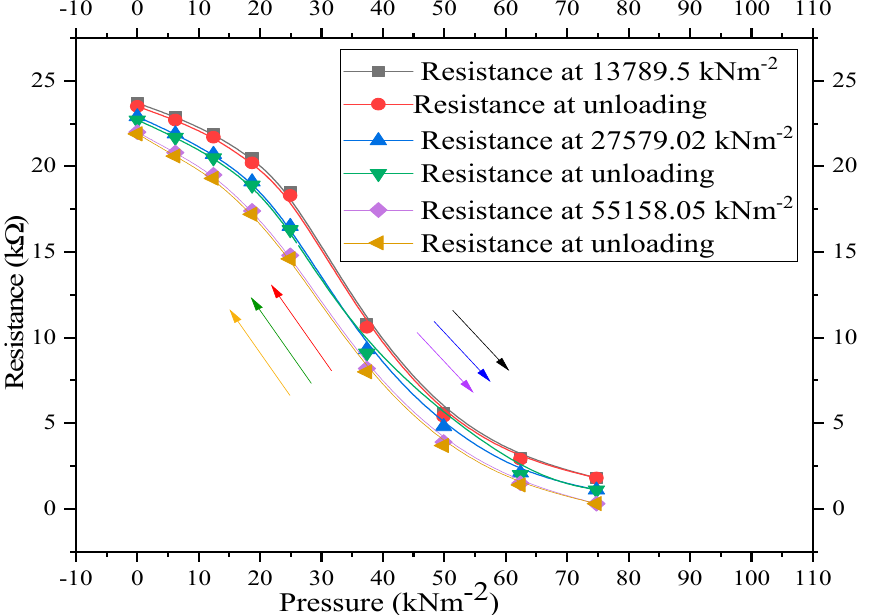
Figure 6. Resistance–pressure characteristics for CNT–graphene composite-based piezoresistive pressure sensors under cyclic loading.